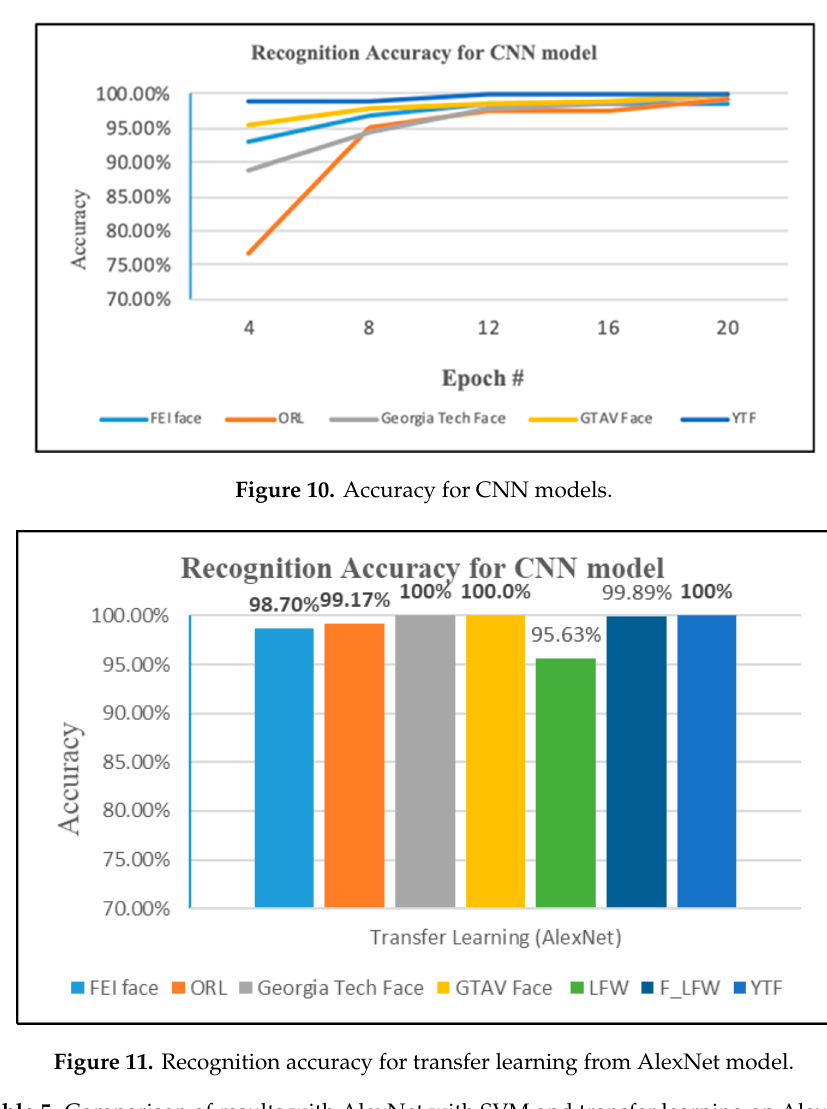
Table 5. Comparison of results with AlexNet with SVM and transfer learning on AlexNet. Figure 11. Recognition accuracy for transfer learning from AlexNet model. FEI Face